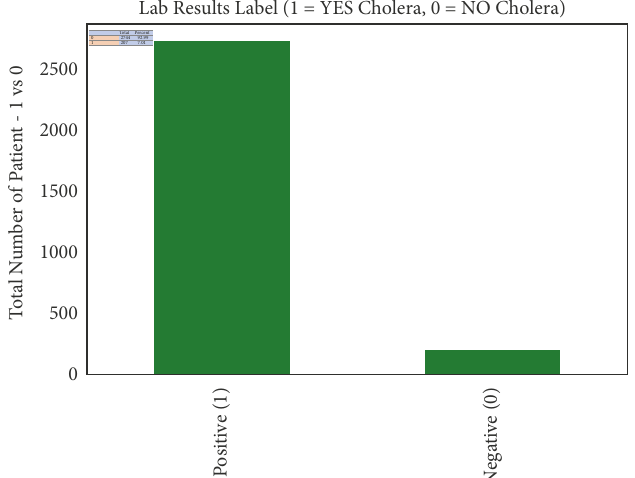
Figure 6: Imbalanced cholera